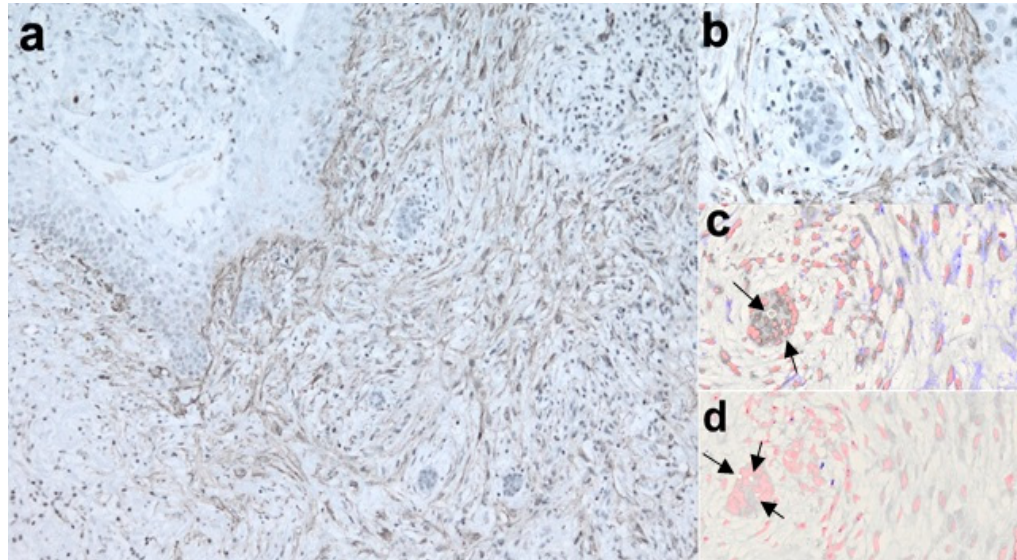
Figure 1. Interaction between epithelial cells and myofibroblasts during connective wall invasion in NBCCS-OKC. ( a ), α SMA staining depicts myofibroblasts surrounding invading epithelial droplets (LSAB-HRP, ×10; nuclear counterstaining with hematoxylin); ( b ), further magnification of a (LSAB-HRP, ×40); invading droplets have been further examined on serial sections by digital pathology showing high expression of MMP-7; ( c ), digital pathology, ×40, MMP-7 in violet and nuclear staining in red pseudocolors); ( d ), digital pathology ×40, MMP-9 in violet and nuclear staining in red pseudocolors), whereas MMP-9 showed a low level of expression [arrows indicated area of epithelial nuclei].